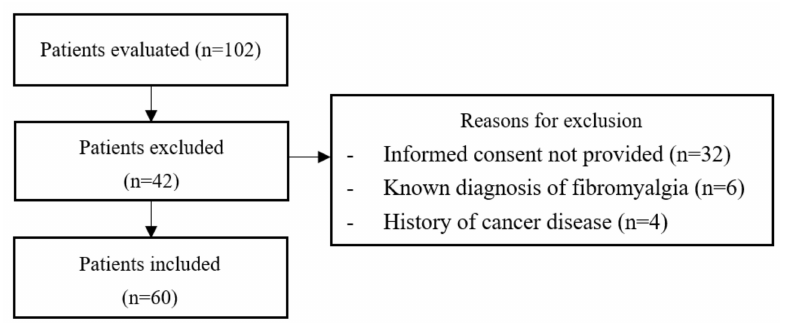
Figure 1. Patients